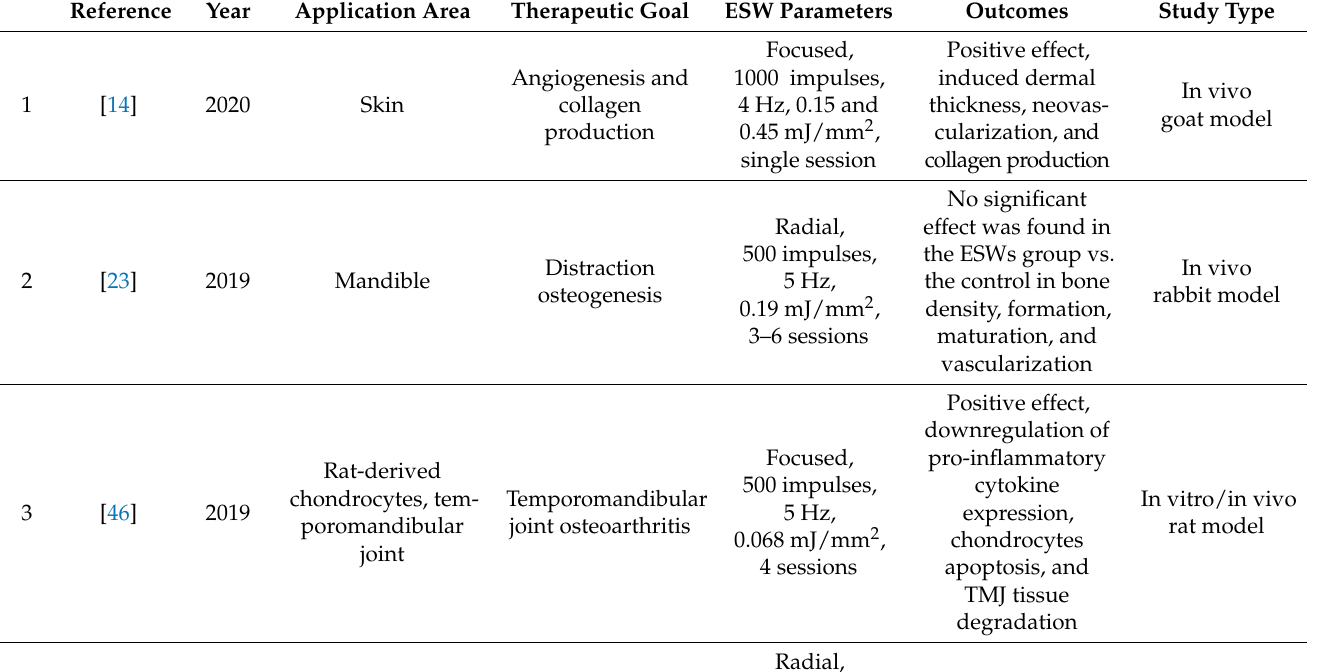
Table 2. Extracorporeal shock wave therapy (ESWT) applications in preclinical studies related to the oral and maxillofacial